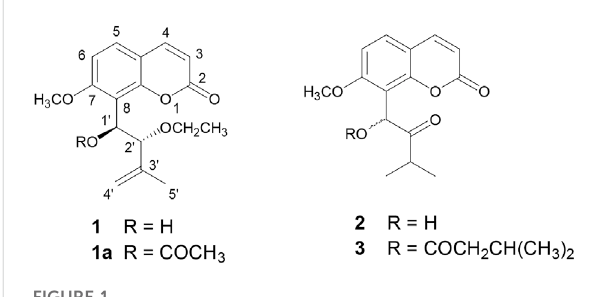
FIGURE 1 Strcutures of isolated coumarins from Murraya